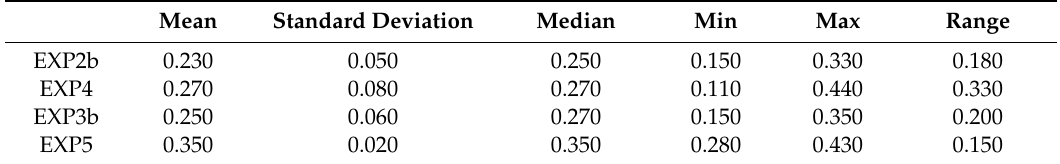
Table 24. VWC (m 3 m − 3 ) (0–10 cm) simulated by UTOPIA and NOAH, initialized with GLDAS, at the CF station.